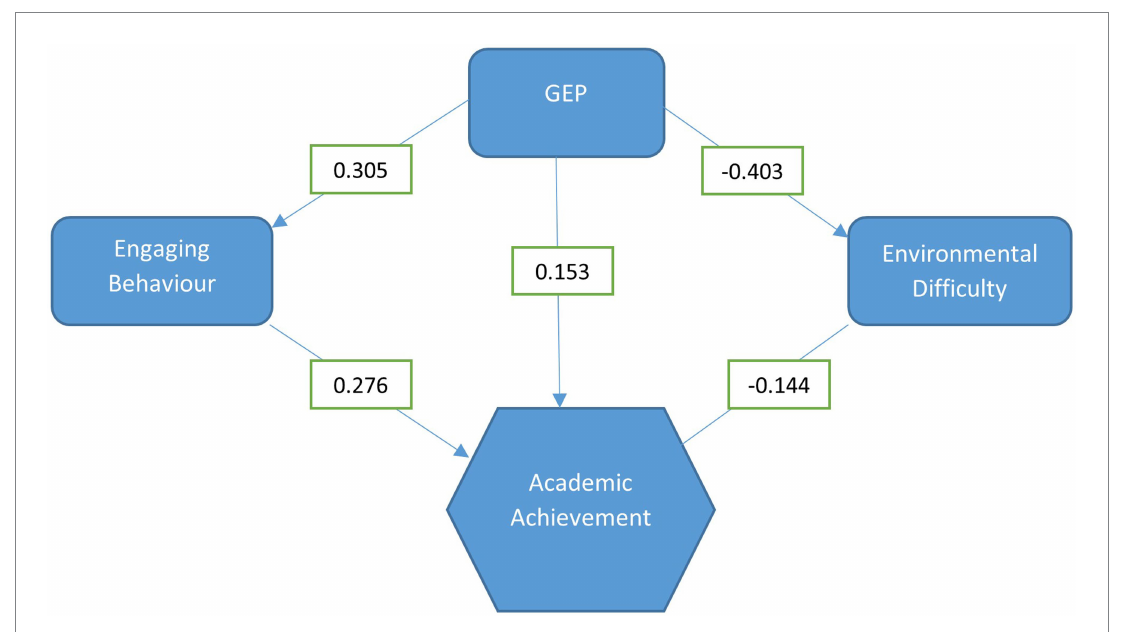
FIGURE 1 Relationship between global environmental perceptions and academic